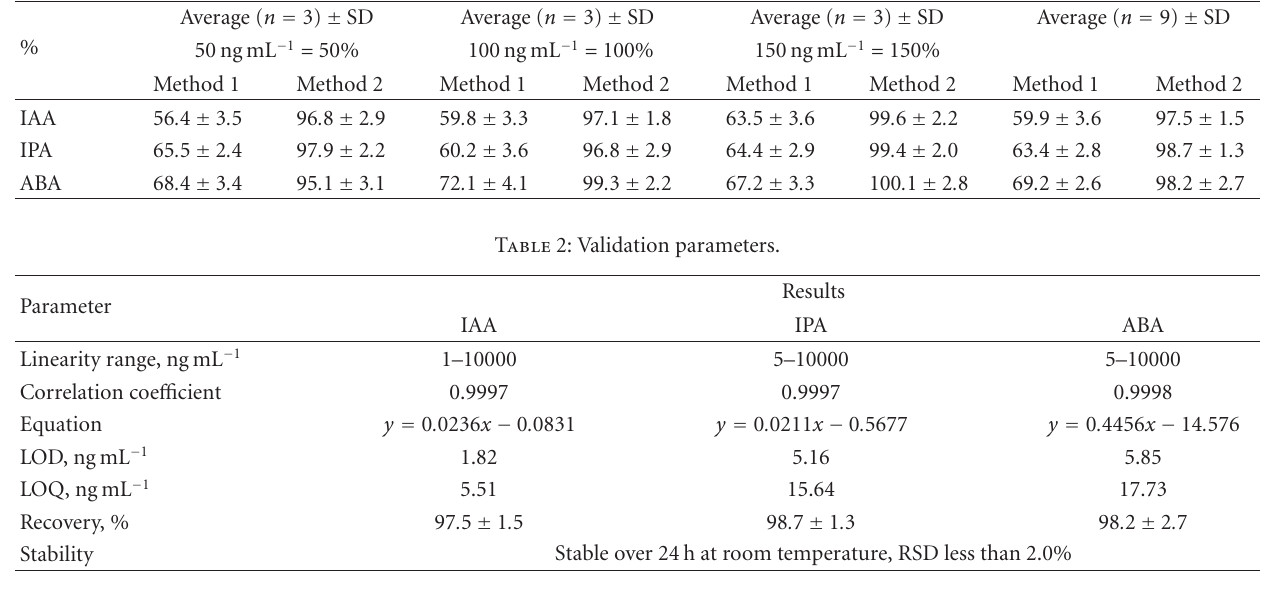
Table 1: Recovery studies of IAA, IPA, and ABA in spiked barley samples.